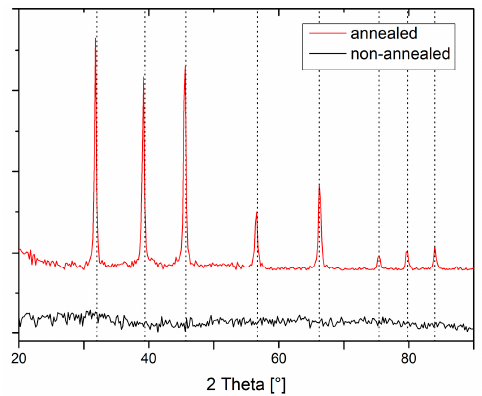
Figure 4. 19 F MAS NMR of non-annealed xerogel 12 , star: rotational side band, υ rot = 20 kHz.